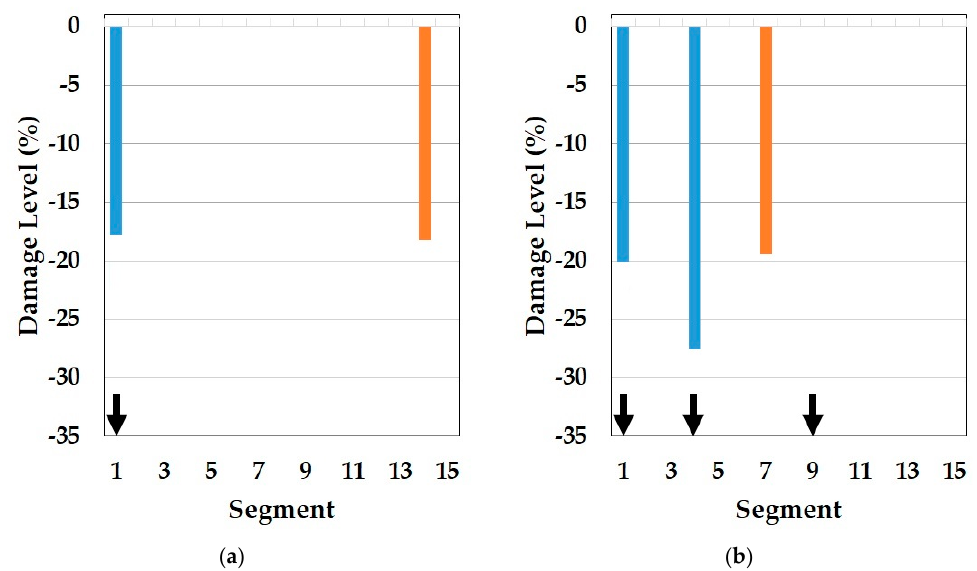
Figure 10. Result of damage detection with updated model F in the reference (blue color is correct segment whereas orange color is incorrect segment): ( a ) DS1; ( b ) DS2.